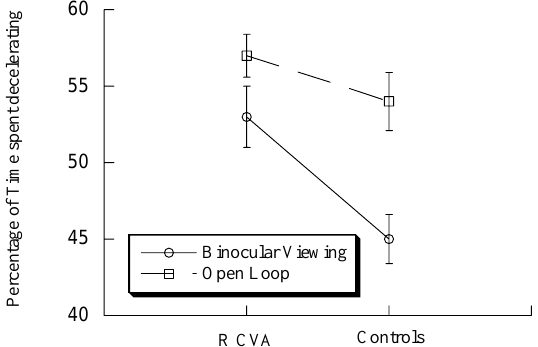
Fig. 5. Percentage of Time spent decelerating under binocular and open loop viewing conditions, separately for the R CVA patients (with and without neglect) and the control subjects using their right hand. Again, error bars indicate